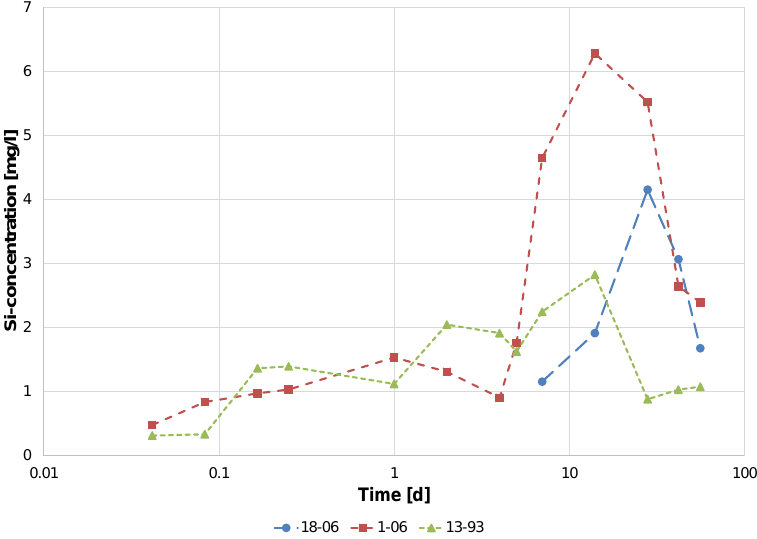
Figure 5. Concentration of silicon ions in SBF in relation to